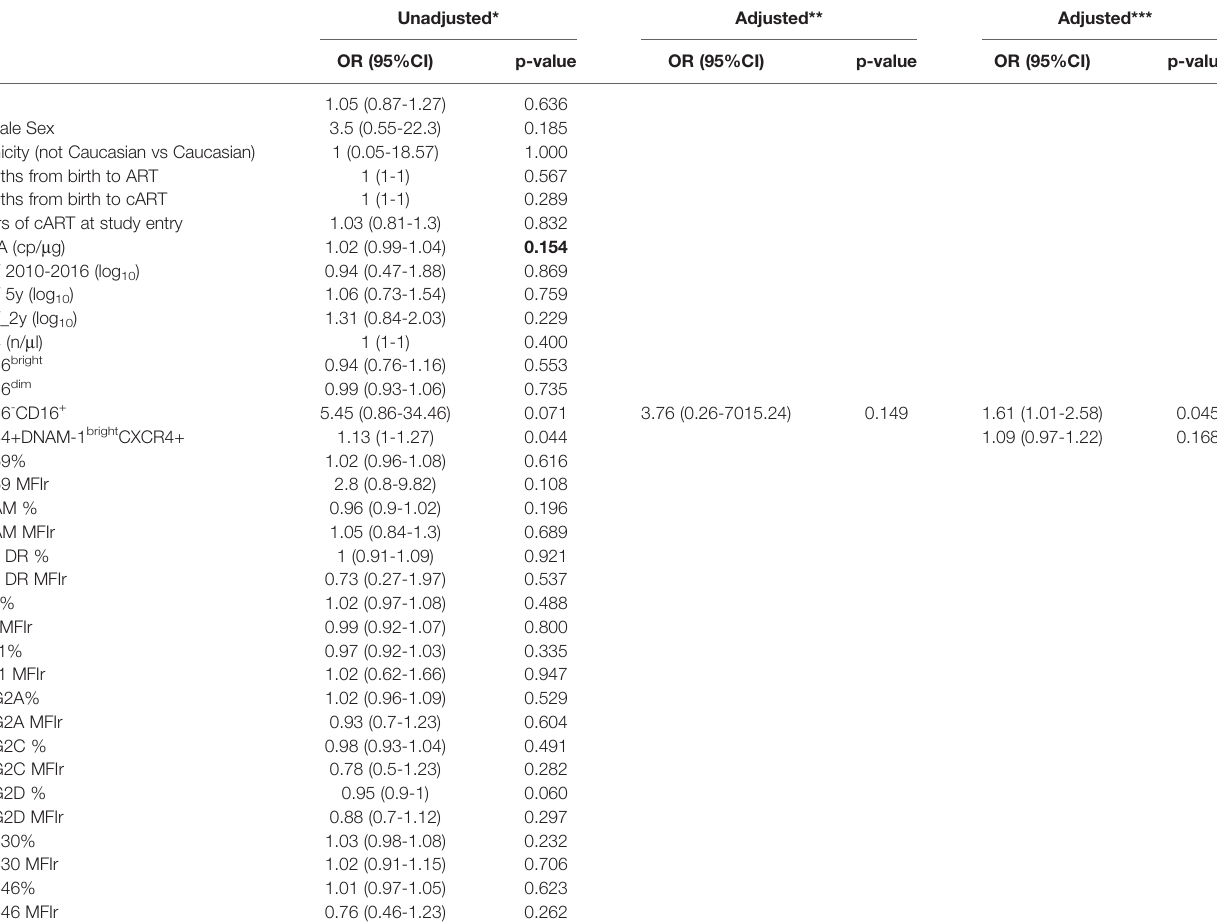
TABLE 3 | Association between presence of unintegrated DNA (uDNA), clinical, laboratory data and Natural Killer (NK) cell molecules